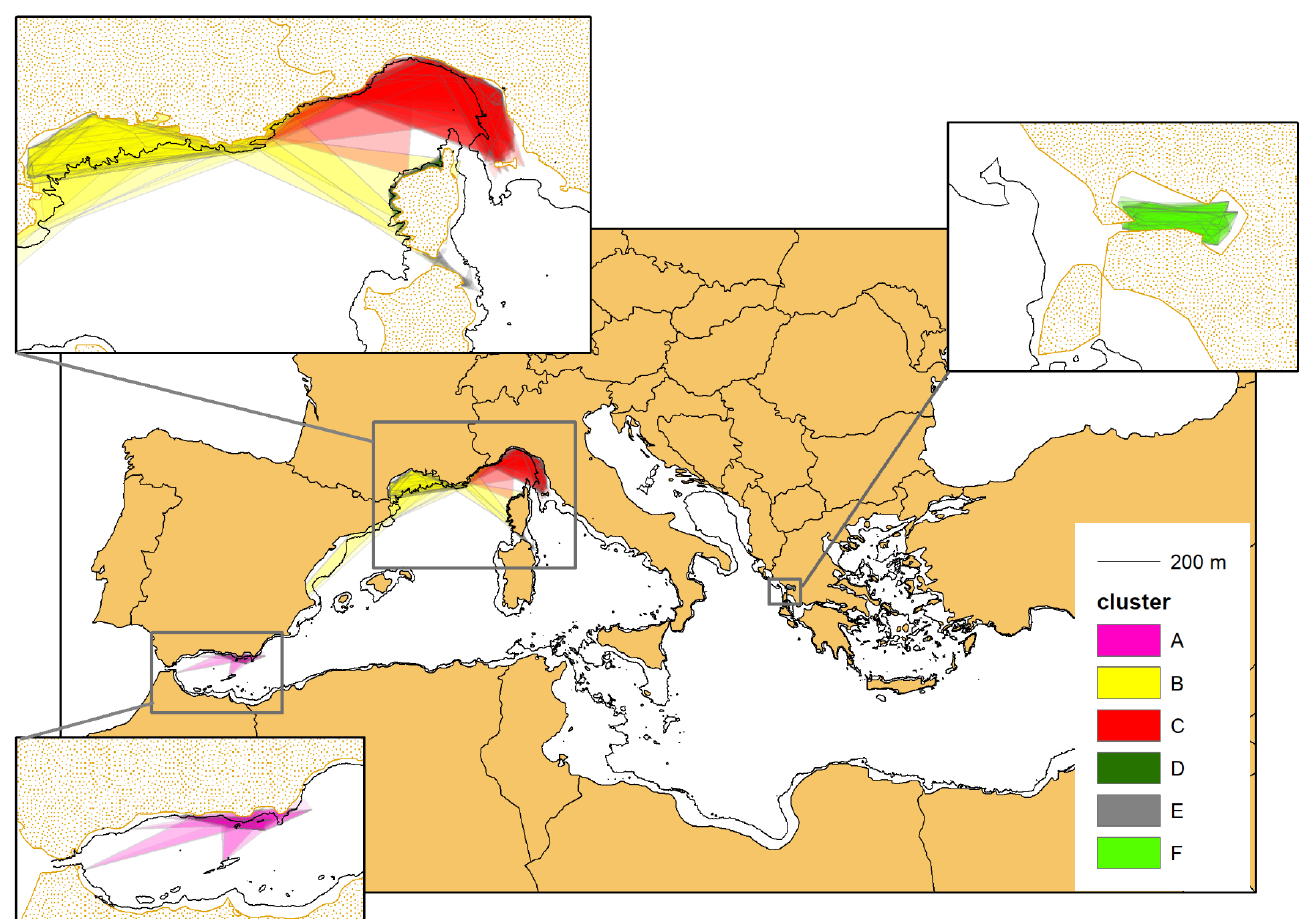
Figure 7. The minimum convex polygons (MCPs) of the photo-identified bottlenose dolphins with at least four captures (703 individuals). The colours correspond to the belonging cluster (see Figure 4). When calculating the surface area (in km 2 ) of the individual MCPs, the portion lying outside the 200 m isobath, delimiting the boundaries of the bottlenose dolphin habitat, was cropped, except for cluster A (purple colour), residing in the Alboran Sea (see the main text for further details). The boxplot analysis identified a total of 19 outliers among the clusters (Figure